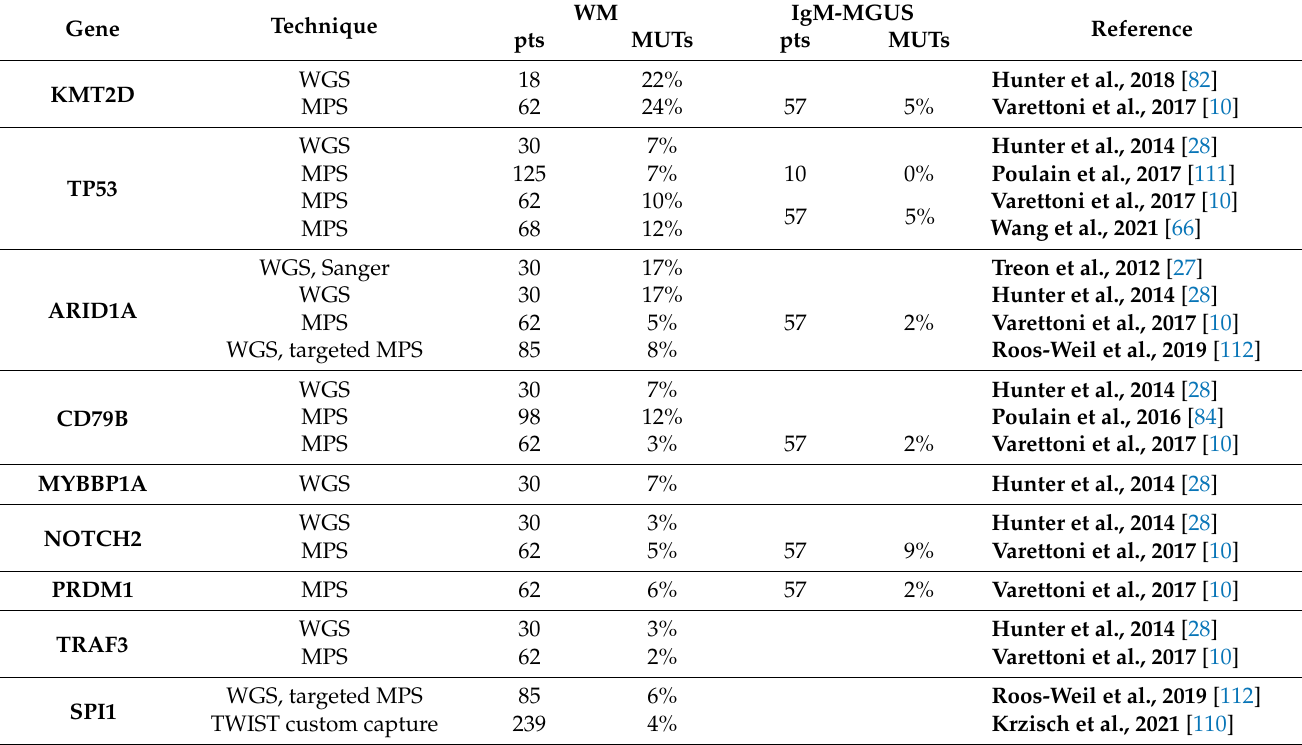
Table 3. Infrequent DNA mutations in WM and IgM-MGUS. pts: patients; MUTs: mutations; WM: Waldenström macroglobulinemia; MGUS: monoclonal gammopathy of undetermined